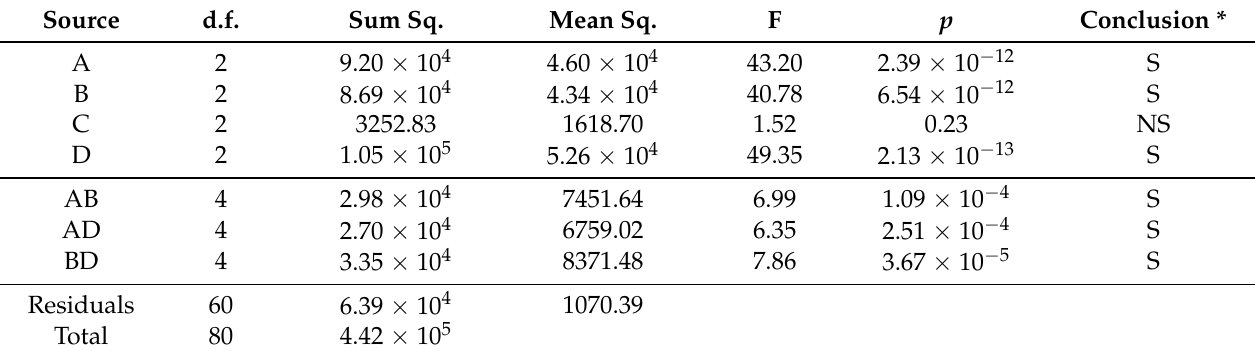
Table 11. Toughness results for the reduced model four-factor ANOVA.